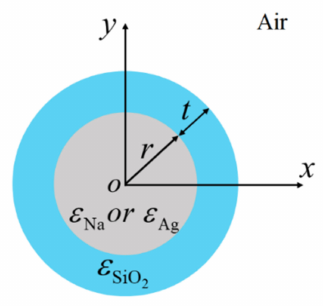
Figure 2. The cross-section of dielectric-coated Ag or Na nanowire.